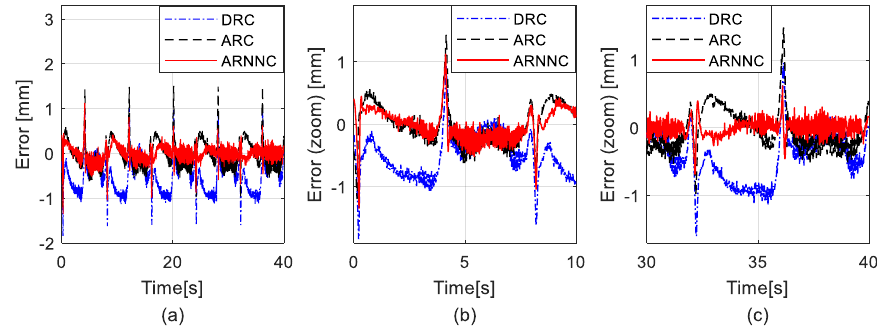
Figure 5. Tracking performances of 90Sin ( 0.25 π t − 0.5 π ) ( a ) Tracking errors of di ff erent controllers. ( b ) Zoomed tracking errors from 0 to 10 s. ( c ) Zoomed tracking errors from 30 to 40 s.